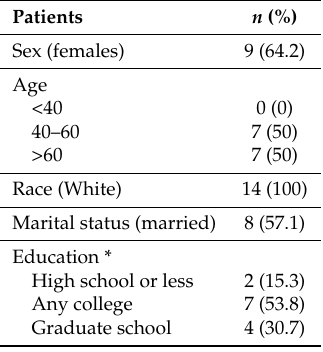
Table 4. Demographic characteristics of patients interviewed ( n =